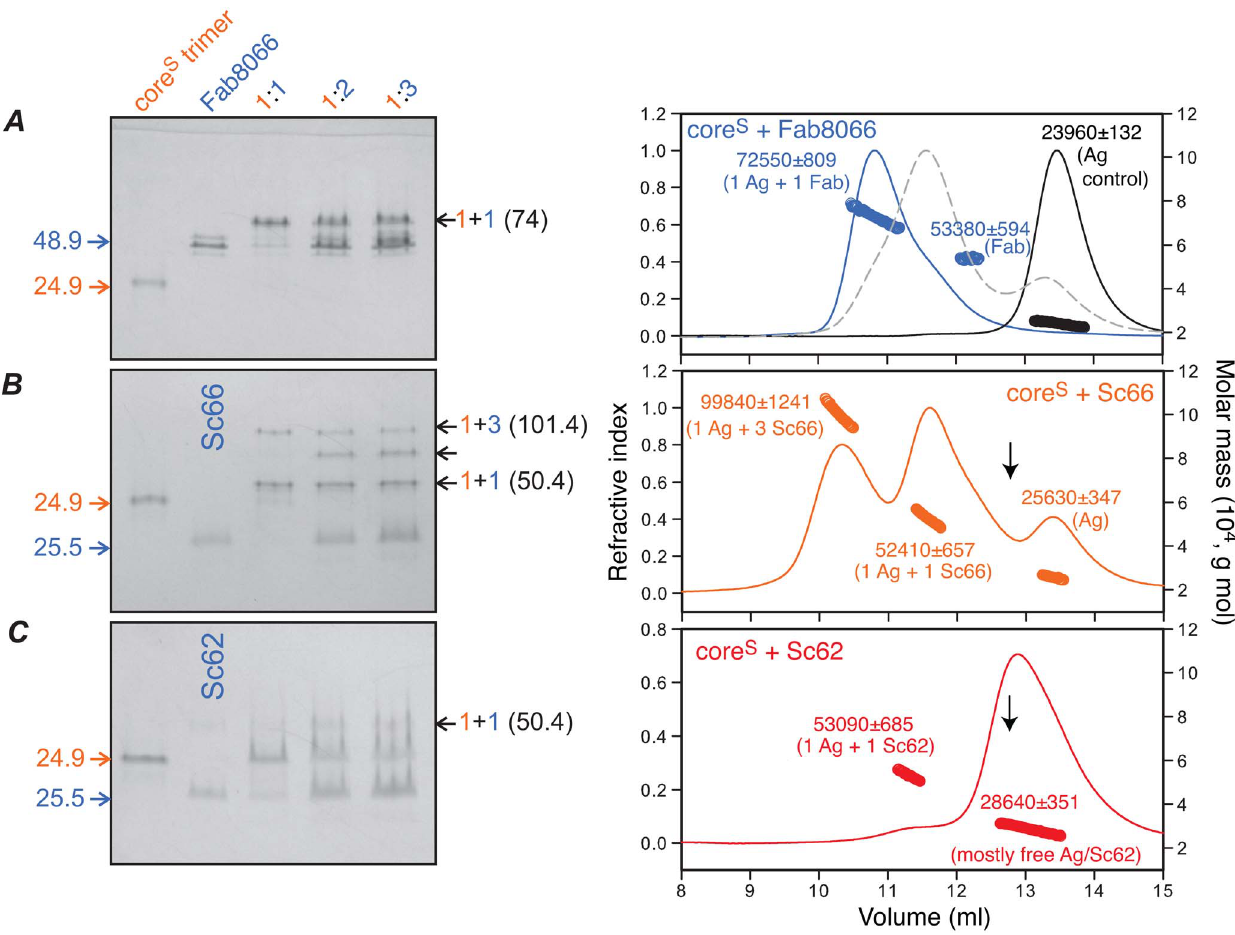
Figure 3. Native-PAGE band-shift and SEC-MALS analyses of core S -antibody complexes. Interaction of ( A ) Fab8066, ( B ) Sc66 and ( C ) Sc62 with the six-helix bundle core S antigen (Ag). Left panels: 10 m M core S trimer mixed with Fab or ScFv (shown above the lanes) in molar ratios of 1:1, 1:2 and 1:3 were subjected to 20% homogeneous native-PAGE. Core S and antibody are color coded orange and blue, respectively. Calculated molecular weights of Fab8066, Sc66, Sc62, core S and their complexes are indicated in kDa. Right panels: Protein mixtures (total of 200 m g) at a trimer (core S ) to antibody ratio of 1:1 were subjected to SEC-MALS. Experimental average masses and compositions are indicated. Also shown in panel A (right) are the SEC-MALS traces for core S alone (black), corresponding to a trimer (of calculated mass 3 6 8284 g/mol), and a 1:1 mixture of core S and Fab8062 (dashed gray) which shows no evidence of complex formation. The black arrows in panels B and C (right) indicate the retention volume of Sc66 (see Figure S2C in File S1). In panel C (right), the major peak corresponds to uncomplexed ScFv and core S which co-elute, while the minor peak represents a barely detectable amount of 1:1 Sc62:core S complex. Observed masses (g/mol) for free Fab8066, Fab8062 and Sc66 are 47060 6 559, 48560 6 629 and 27630 6 774, respectively.